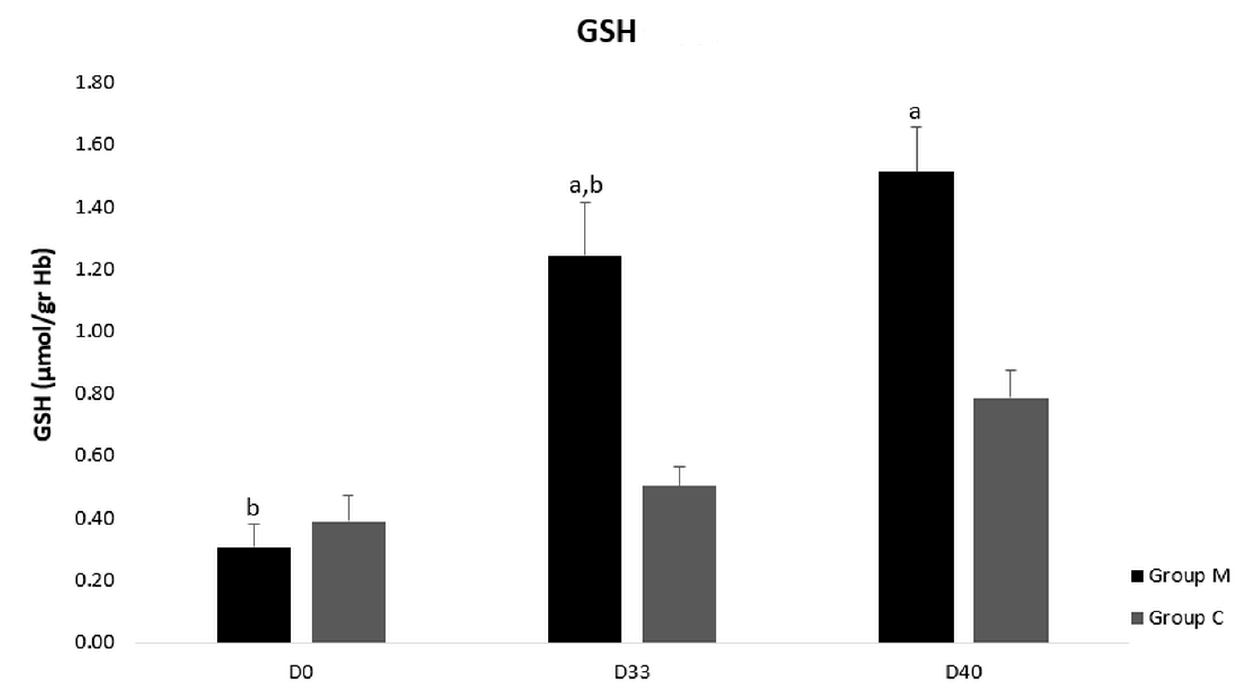
Figure 4. Glutathione (GSH) levels in blood plasma of group M (melatonin) and group C (control) at three time points of the study. a: Difference between the two groups, b: Difference between the three time points in group M or group C; p ≤ 0.05.